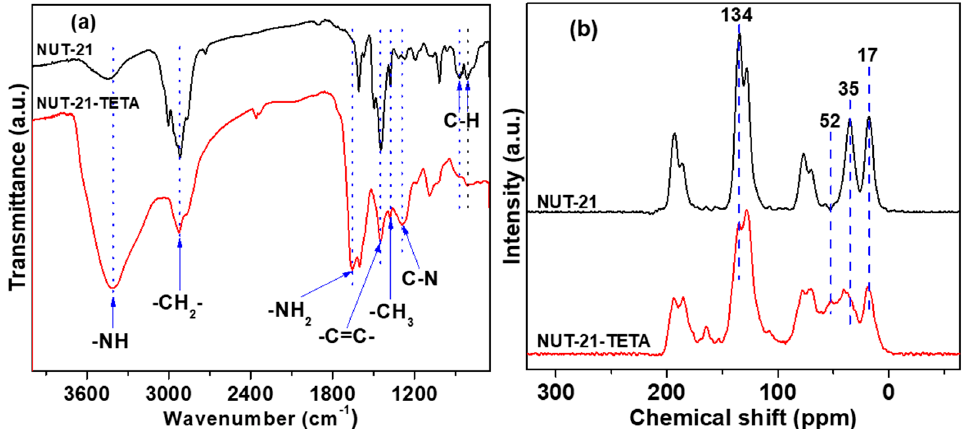
Figure 1. ( a ) IR spectra of NUT-21 and NUT-21-TETA, ( b ) solid-state 13 C NMR spectra of NUT-21 and NUT-21-TETA.